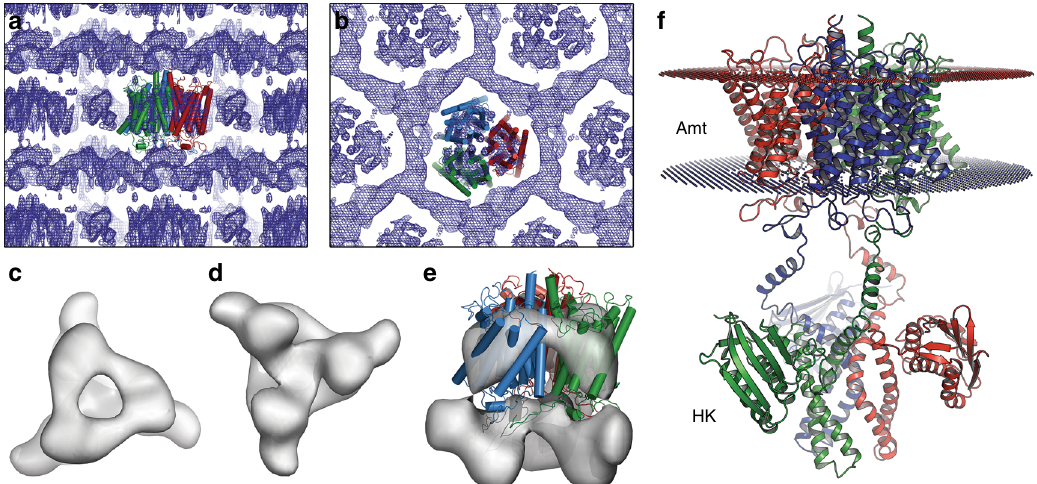
Fig. 4 Low-resolution analysis of full-length Ks -Amt5. a Electron density map showing the strata of the type I crystals, with the high-resolution structure of the Amt domain placed and shown in cartoon representation. b Top view of a . The electron density map is better resolved for the Amt domain that determines the crystal packing, whereas the HK domain shows disorder and attains a position between neighboring Amt domains. c Top view of full-length Ks -Amt5 in a weighted electron density synthesis at 8 Å resolution contoured at the 1 σ level. d Bottom view onto the HK domain. e Low-resolution electron density synthesis of Ks -Amt5, superimposed with the high-resolution 3D structure of the Amt domain. f Hypothetical, extended arrangement of the sensor- transducer in the membrane, showing the structure of the Amt domain linked to a homology model for the HK domain in an arbitrary, extended conformation. The HK domains are structurally fl exible in the cytoplasm, and their conformation in solution is not identical to the one observed in the crystal lattice (Supplementary Figure